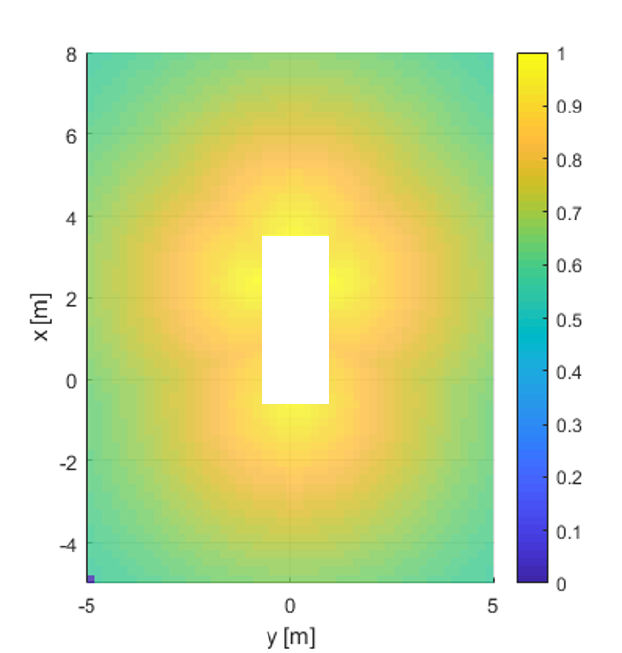
Figure 4. The perceptional error model from an AVM system to an